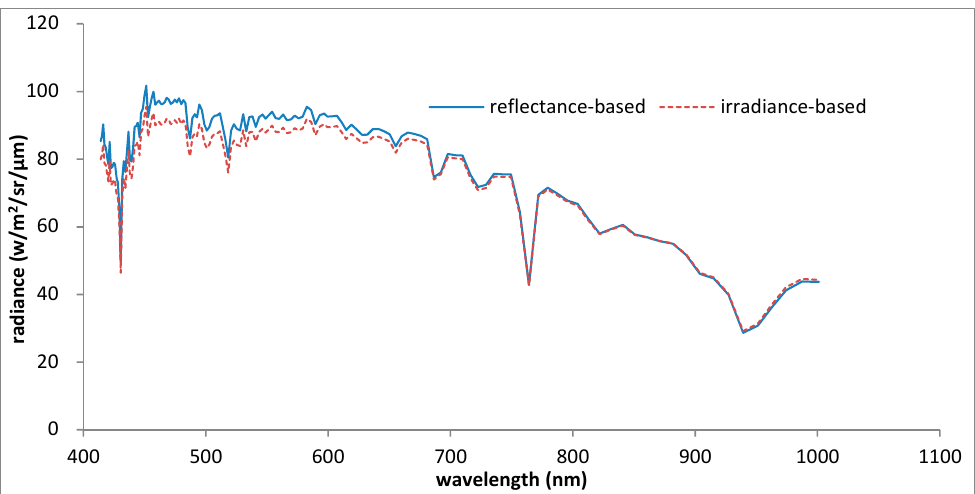
Figure 21. MODTRAN-simulated radiance for the SPARK-01 satellite calculated using both reflectance- and irradiance-based methods.